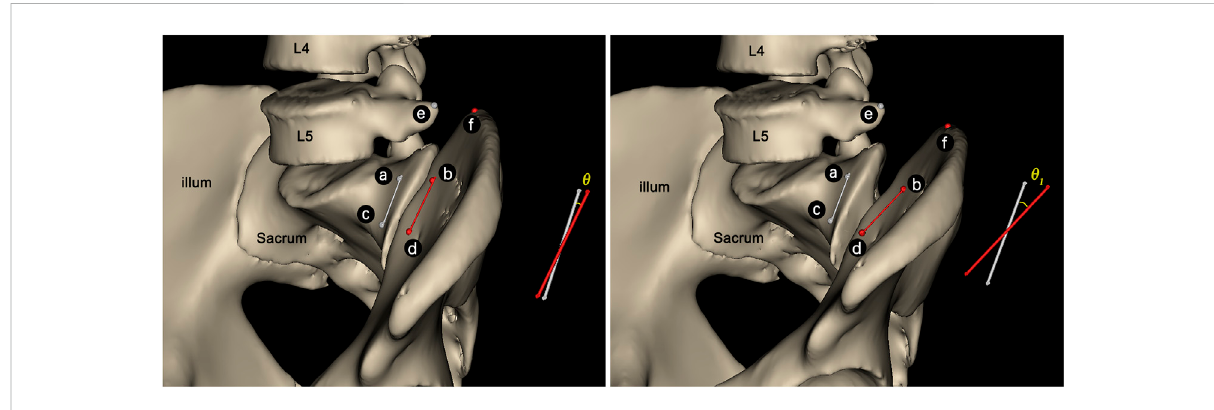
FIGURE 3 Sketch of θ angle between the line (A,C) and line (B,D) . The angle would increase to θ 1 along with the SIJ nutation (C)